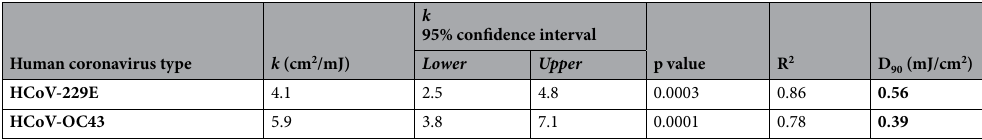
Table 1. Linear regression parameters for normalized ln[S] [survival] values (equation 1) as the dependent variable and UV dose (D, mJ/cm 2 ) as the independent variable. k is the UV inactivation rate constant or